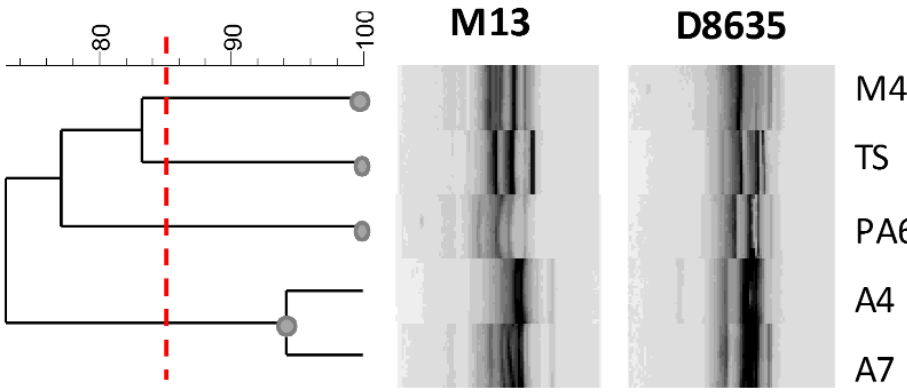
Figure 5. Dendrogram showing the similarity among RAPD-PCR profiles of L. brevis strains. The red line indicates the cluster cut-off value of 85%, which delimitates the main clusters.